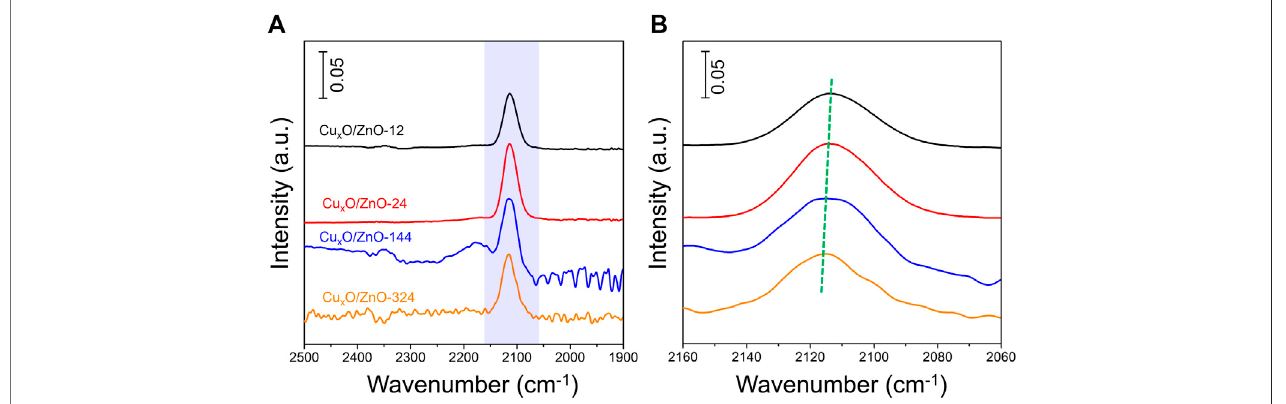
FIGURE 10 | (A) : In-situ DRIFTS spectra of different Cu